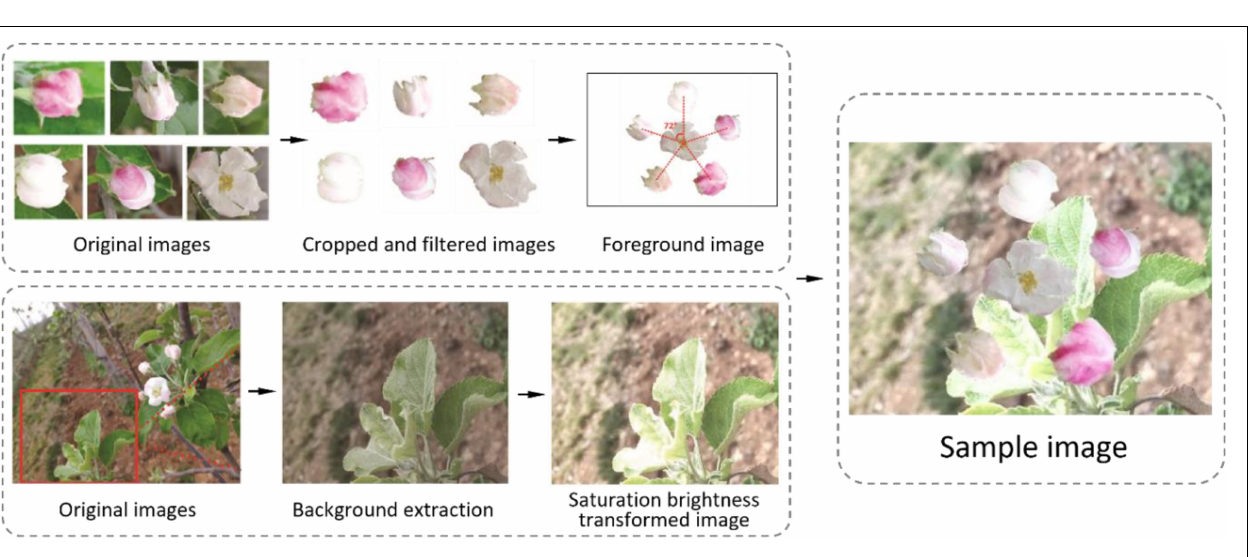
FIGURE 7 | Procedure of image generation in Tian et al.